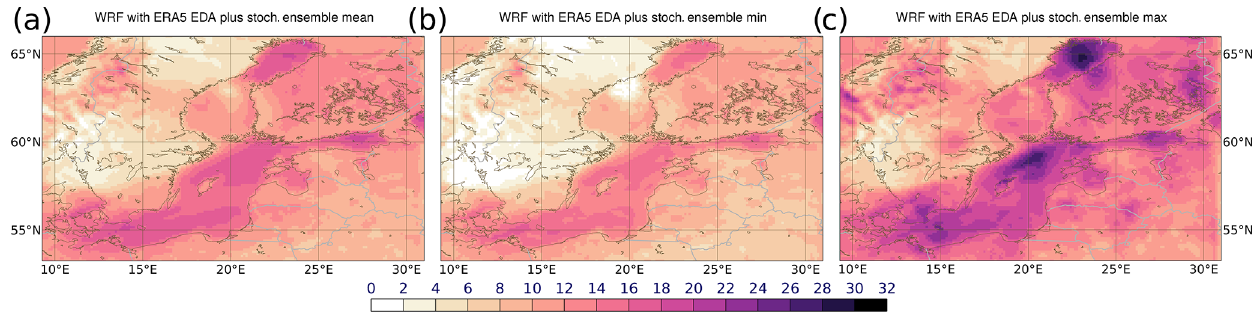
Figure 5. Ensemble mean (a) , minimum (b) and maximum (c) wind speed (ms − 1 ) from WRF ensemble approach number six generated by starting three times 10 members from ERA5 EDA members at 21 February 2002 09:00, 12:00 and 15:00UTC plus stochastic perturbations SPPT and SKEB. Shown are results for the 23 February 2002